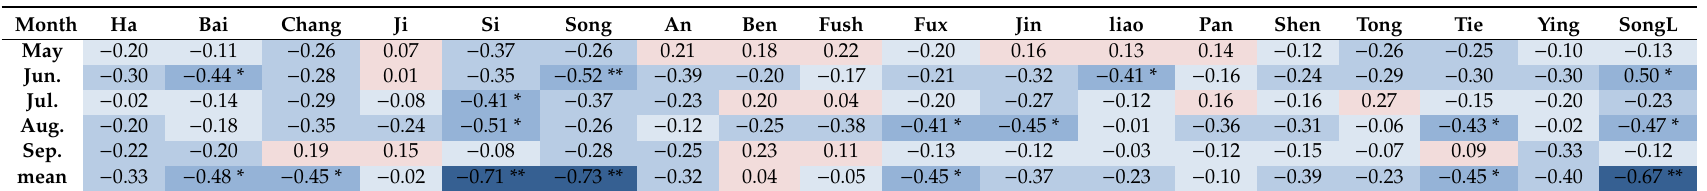
Table 3. Pearson’s correlation coe ffi cient of precipitation and climate yield in the maize growing season in Songliao Plain maize belt during the period 1998–2017. Month Ha